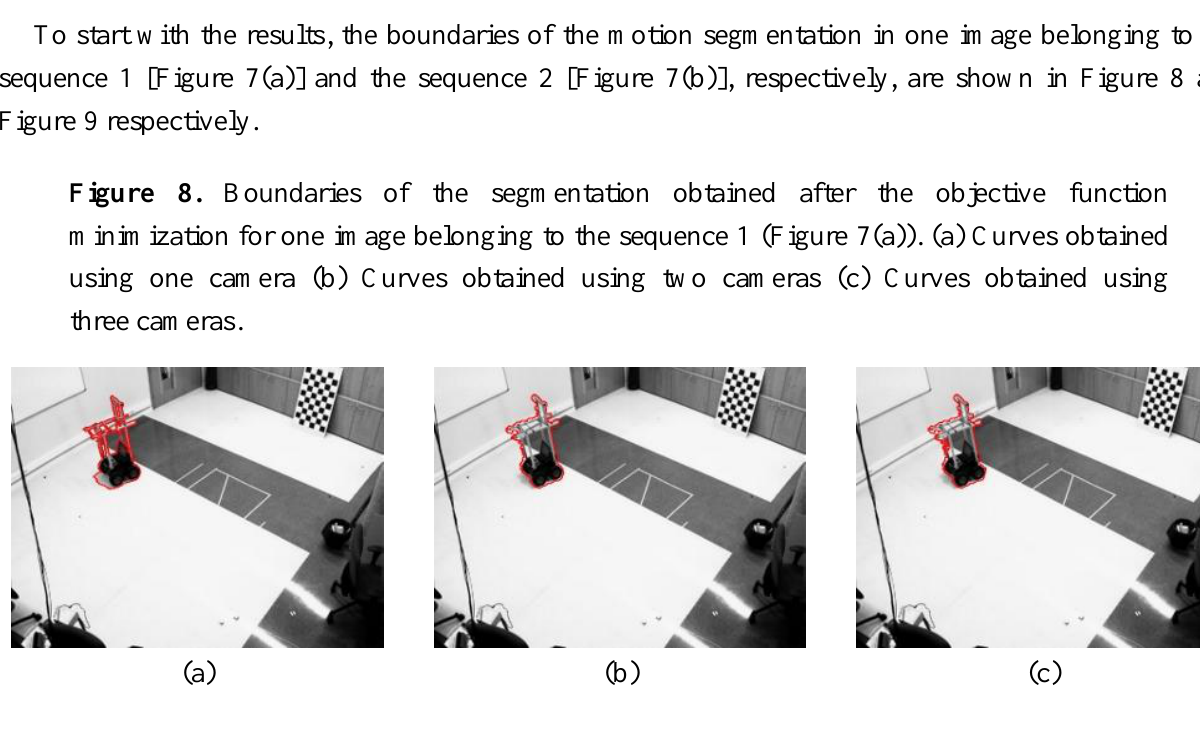
Figure 9. Boundaries of the segmentation obtained after the objective function minimization for one image belonging to the sequence 2 (Figure 7(b)). Each detected object is shown in a different colour (a) Curves obtained using one camera (b) Curves obtained using two cameras (c) Curves obtained using three